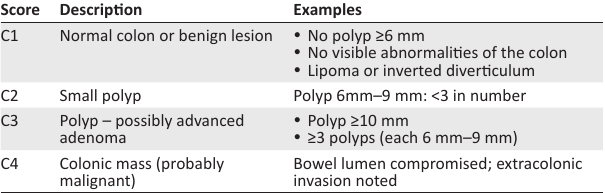
FIGURE 14: Red dot (next to black arrow) indicates lesion site on TABLE 5: Colonic classifications † .